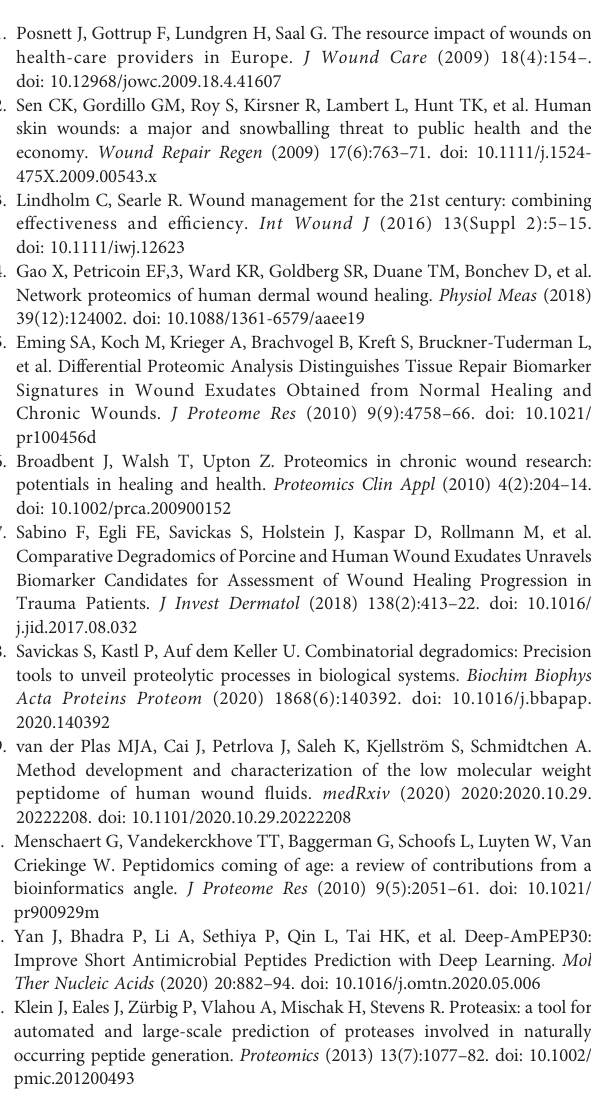
Supplementary Table 5 | The excel fi le containing all the unaltered data retrieved from the antimicrobial peptide prediction tool AmPEP. Supplementary Data Sheet 1 | The folder contains all the peptigrams in their original format. Supplementary Data Sheet 2 | Figure summarizing the bioinformatics approaches, the results, and their signi fi cance as presented in the article. Supplementary Figure 1 | Total spectral count in samples. The bar chart shows the spectral count and standard deviation in samples for the acute, non-infected and infected samples. Supplementary Figure 2 | Figure of outliers. (A) The fi gure shows the average spectral count over the occurrence in patients. The fi gure was used to identify